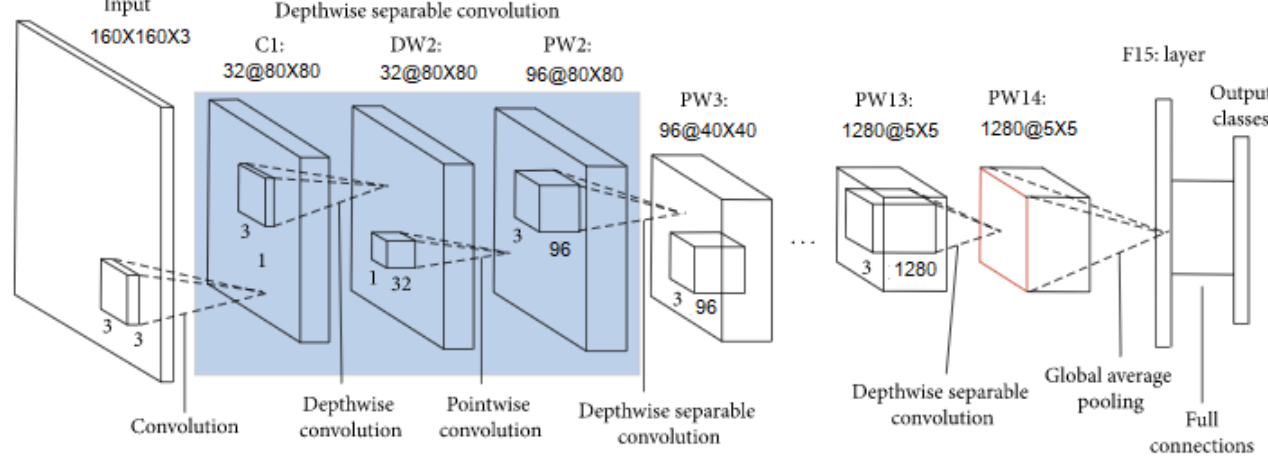
Figure 3. MobileNet-V2 architecture.